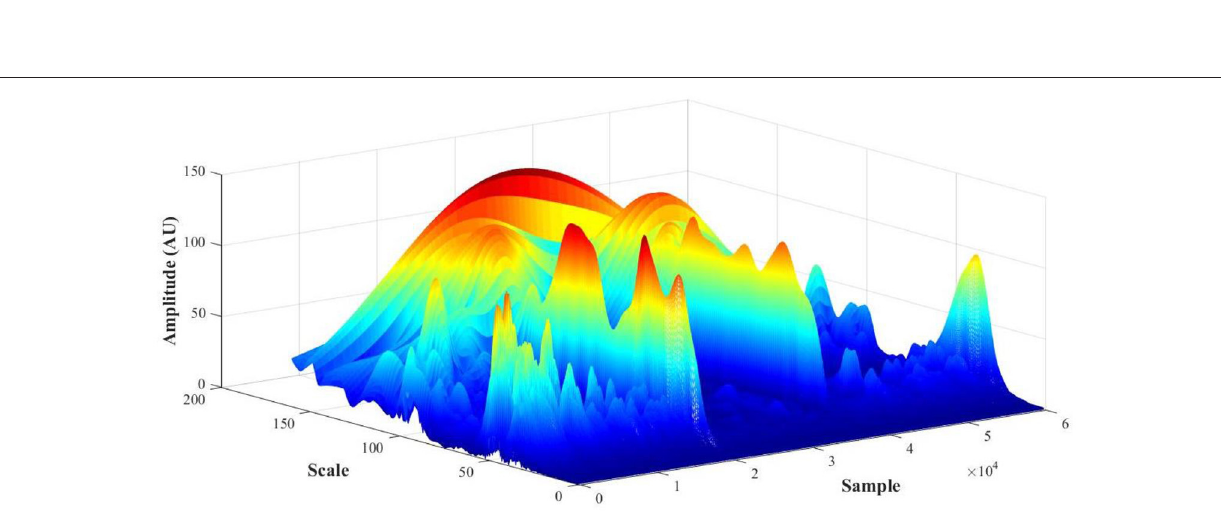
Frontiers in Physiology | www.frontiersin.org